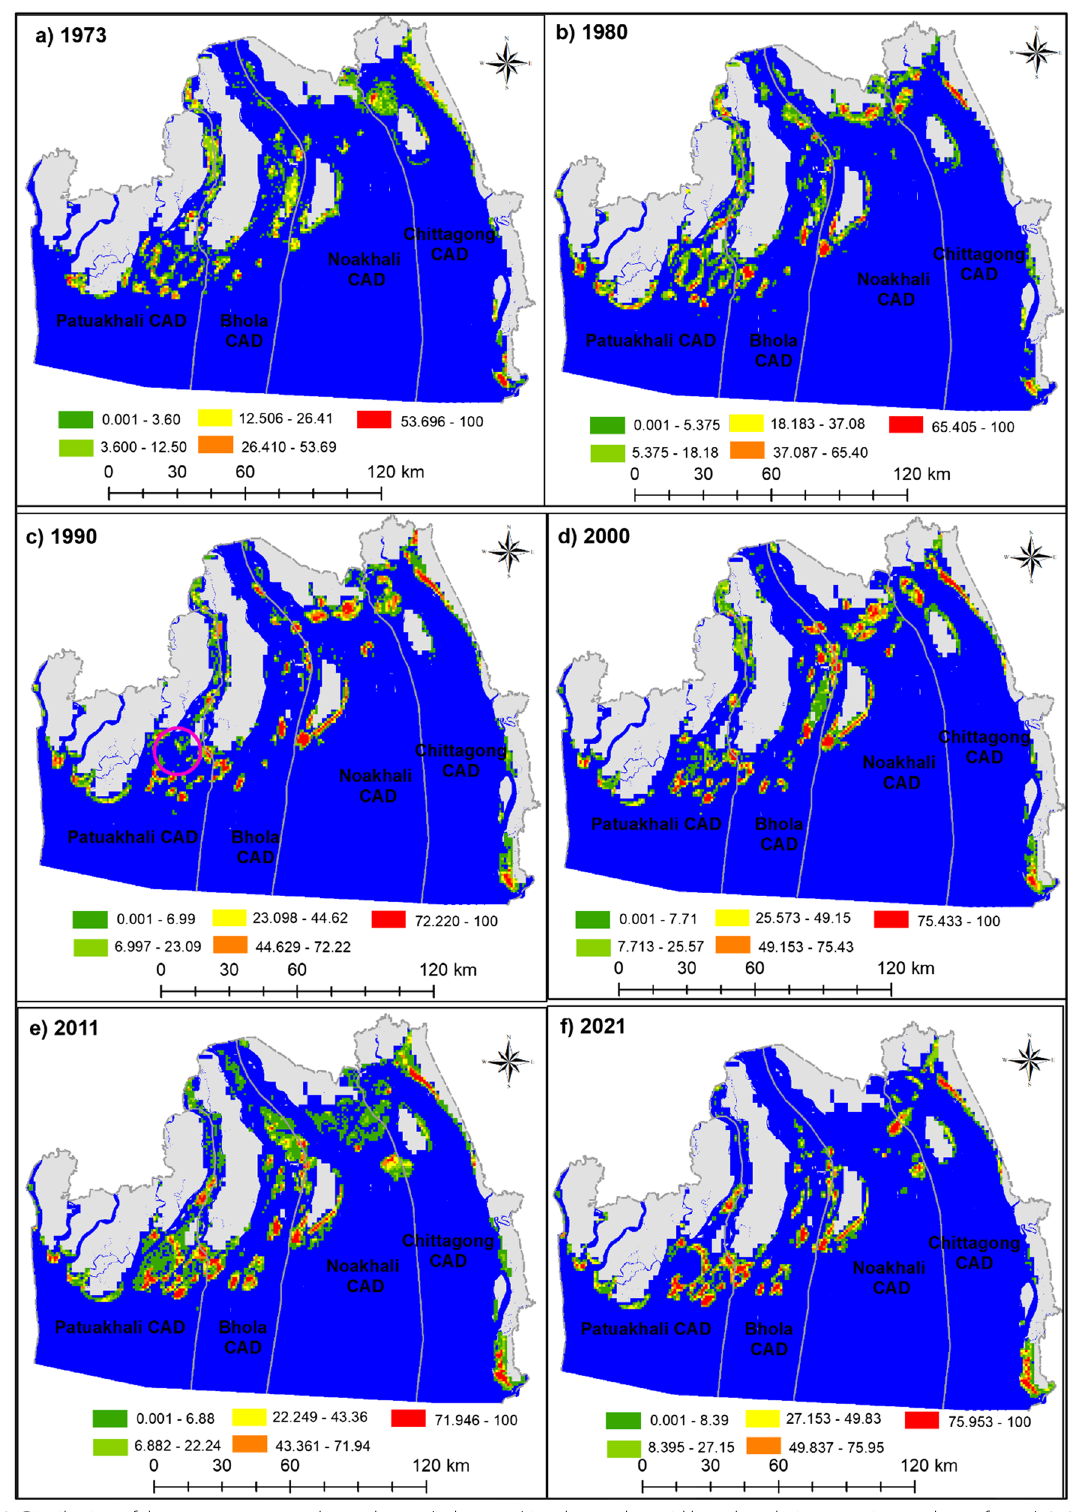
Fig. 12 Distribution of the mangrove across the study area (in hectares) in 1 km